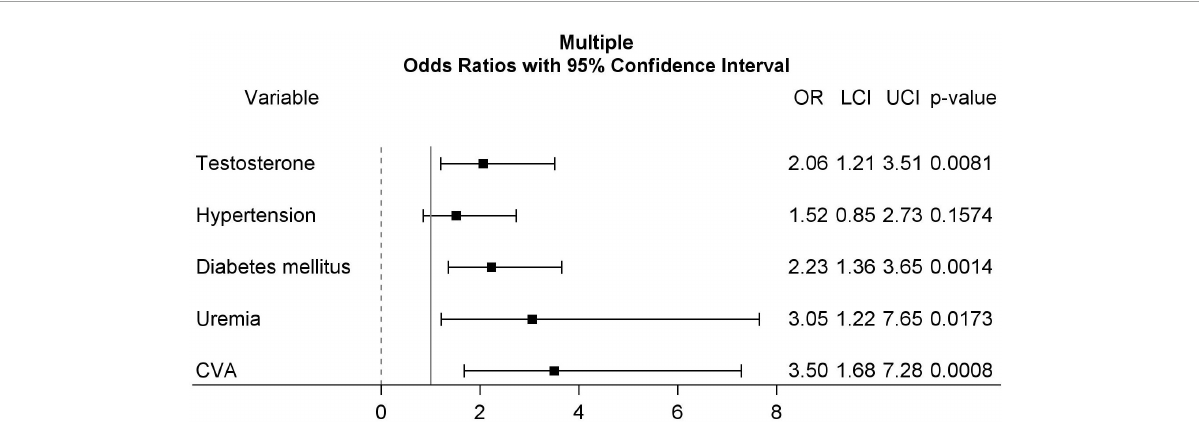
FIGURE2 Forest plots for multiple logistic regression including testosterone ( ≥ 3.25 ng/mL, as reference group), hypertension, diabetes mellitus, uremia, and CVA. CVA, cerebrovascular